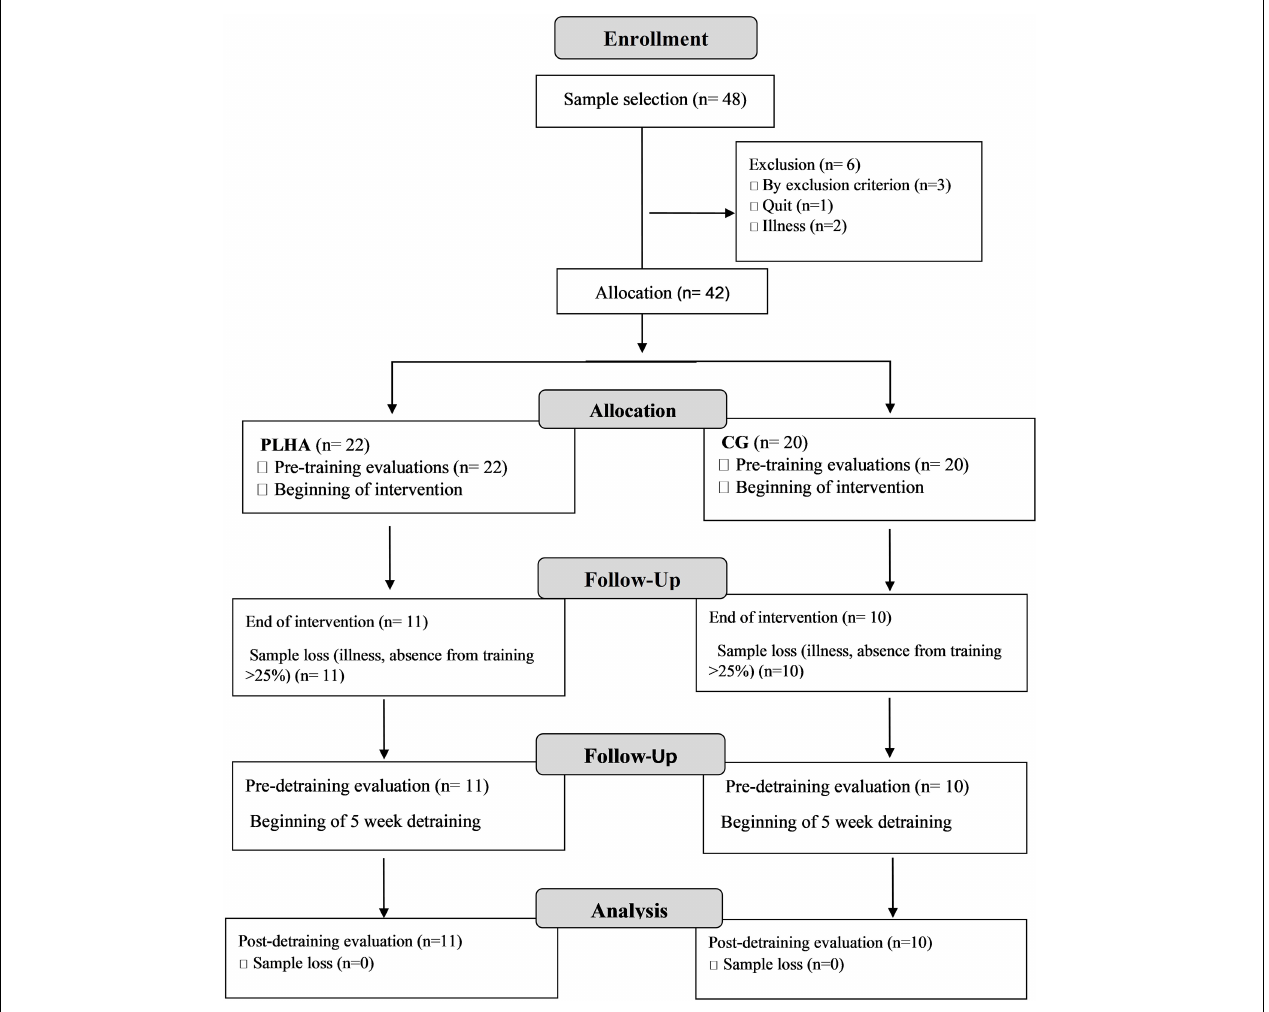
FIGURE 1 | Study flowchart. PLHA, people living with HIV/AIDS group; CG, control group (people without HIV/AIDS); n , number of